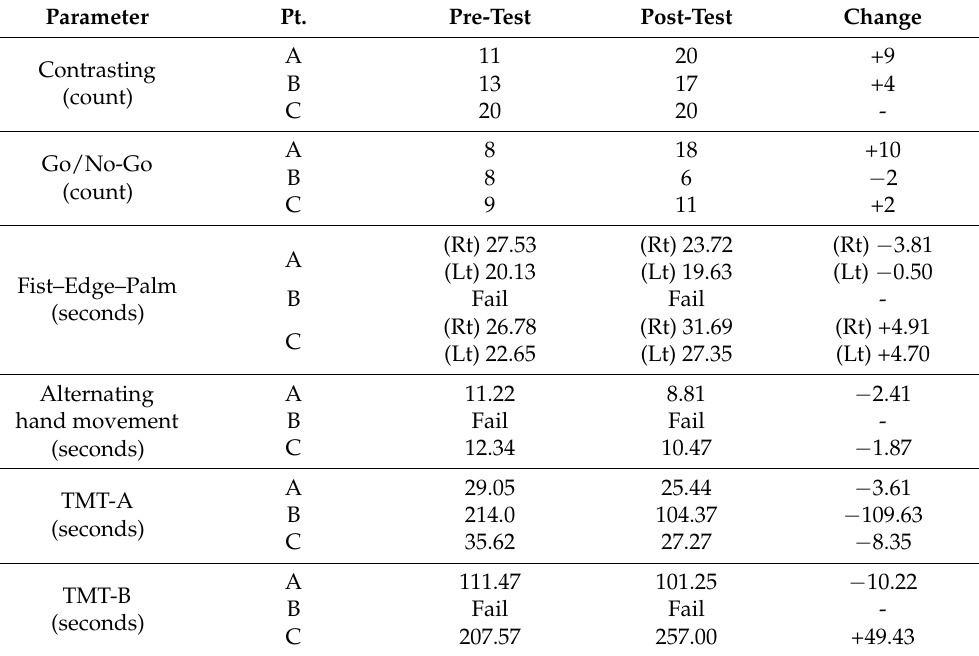
Table 3. Changes in cognitive